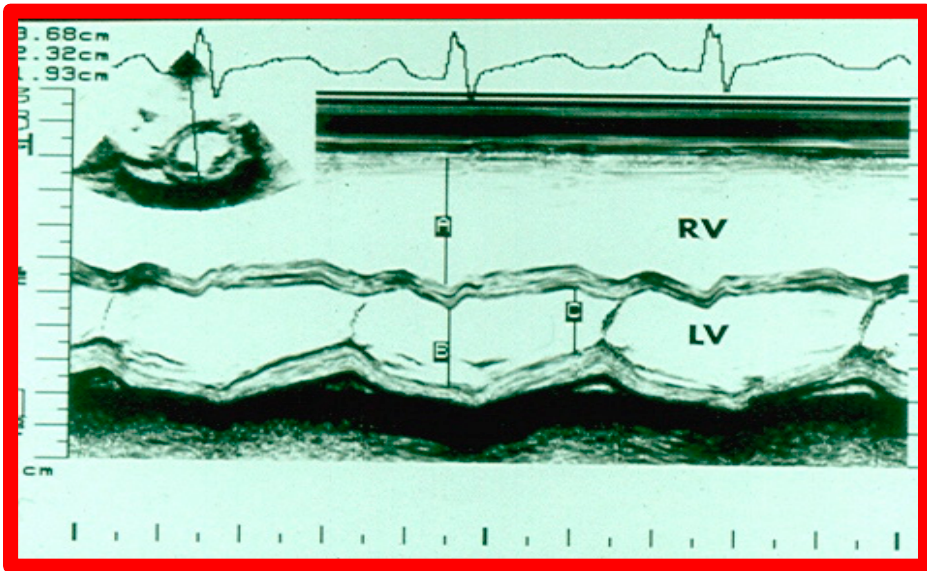
Figure 2. M-mode echocardiogram of a patient with a diagnosis of an atrial septal defect (ASD). It demonstrates dilation of the right ventricle (RV) and paradoxical movement of the interventricular septum in the M-mode recording (2D-derived) in parasternal short axis projection (see lower insert). Normally the ventricular septum functions as a part of the left ventricle (LV); in large ASDs, the septum functions as a part of RV and moves in opposite direction, i.e., paradoxical, also described as “diastolic septal flattening”. The findings are very typical indirect signs of an ASD. A, B, and C stand for measurements of the end-diastolic RV, end-diastolic LV, and end-systolic LV, in that order. The dimensions are shown top left. Modified from Reference [1].